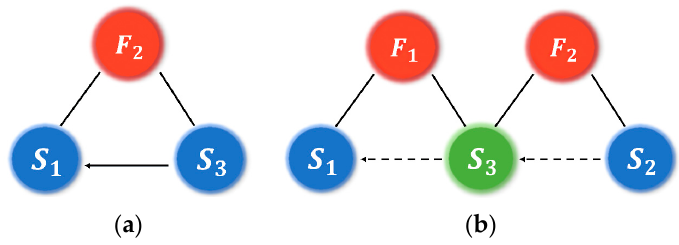
Figure 14. The improved Su-Field model. ( a ) Plan 1; ( b ) Plan 2.